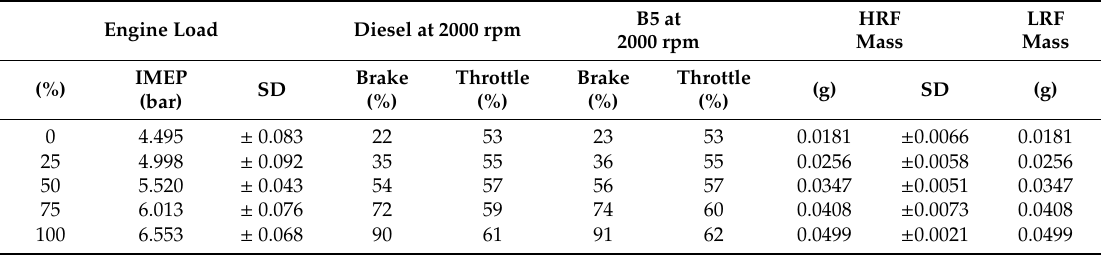
Table 2. Preliminarily estimated test parameters, on average, at various load